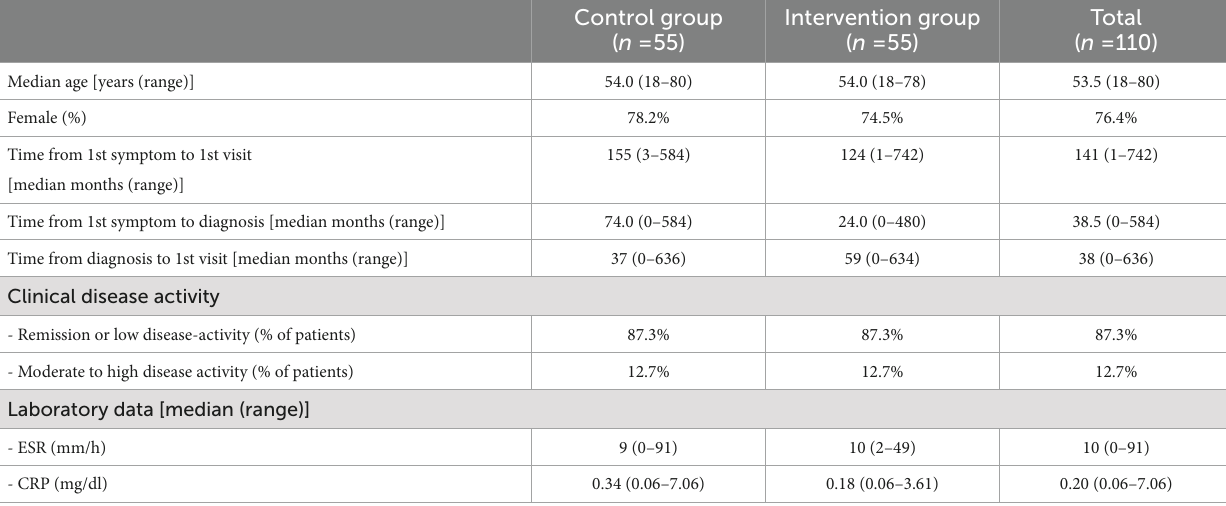
TABLE 1 Patients’ and diseases’ characteristics at study